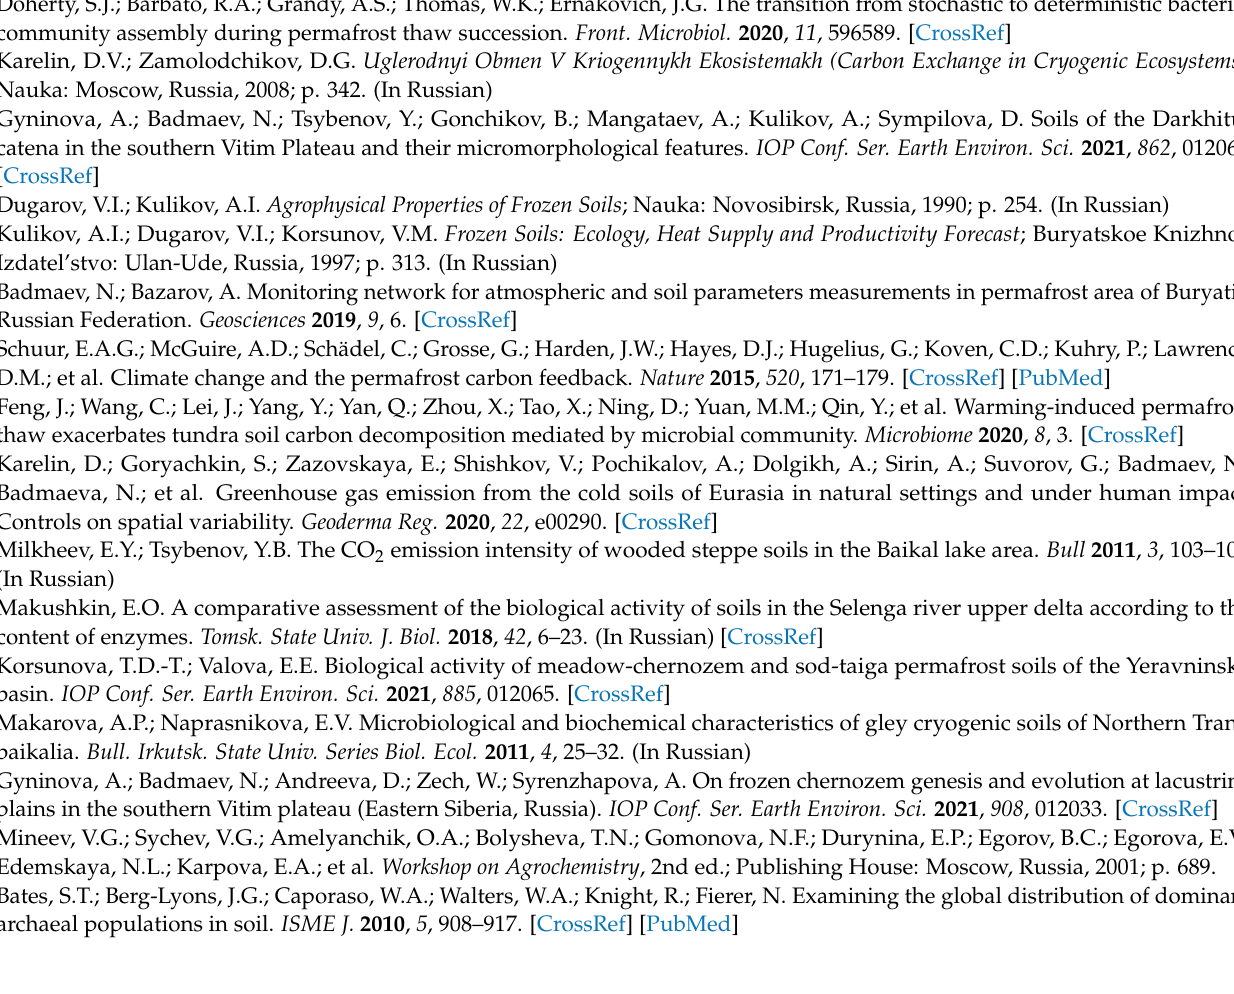
Figure S2: Relative abundance of bacteria and archaea on the class level in permafrost soils along Darkhituy-Khaimisan transect. Figure S3: Relative abundance of bacteria and archaea on the genus level in Darkhituy soils (Sites D1 and D2). Figure S4: Relative abundance of bacteria and archaea on the genus level in Darkhituy soils (Site D3). Figure S5: Relative abundance of bacteria and archaea on the genus level in Khaimisan